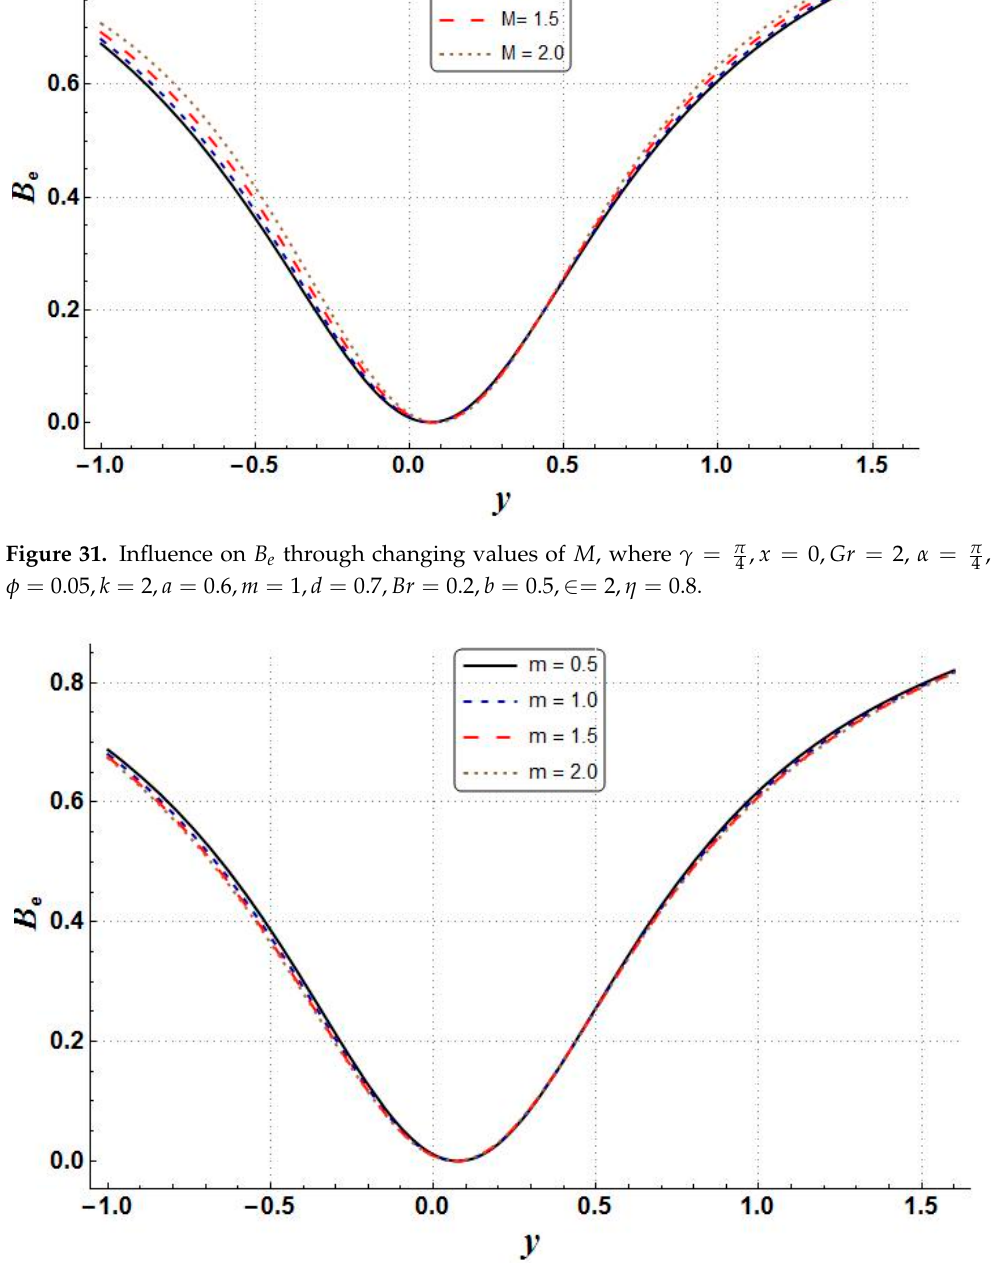
Figure 32. Influence on B e through changing values of m , where γ = π φ = 0.05, k = 2, a = 0.6, M = 1, d = 0.7, Br = 0.2, b = 0.5, ∈ = 2, η =